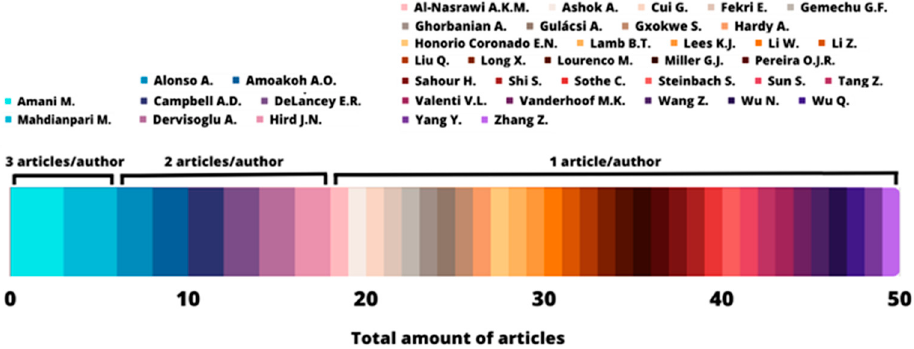
Figure 5. The author’s contribution to the selected articles.